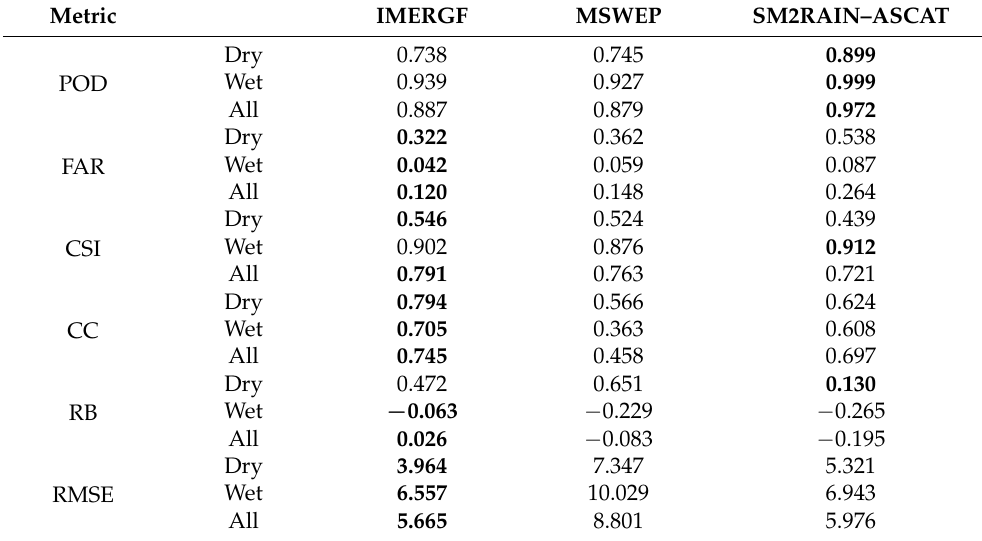
Figure 7. Rainfall performance metrics FAR, RB, and RMSE for ( a ) annual, ( b ) dry, and ( c ) wet seasons. The red dashed line shows the best value. Table 4. The median performance metrics of three SPPs were based on daily rain gauge measurements (2001–2018). Bold values indicated the best score. Larger numbers show better performance except for RMSE and